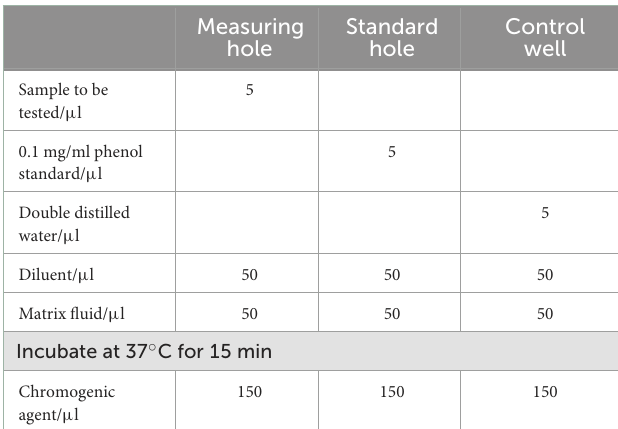
TABLE 1 Determination of alkaline